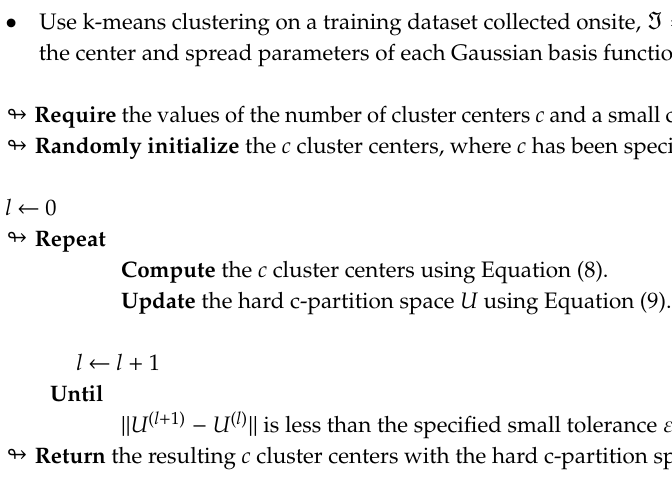
Algorithm 1. The two-stage method developed for the advanced AI k-means clustering-integrated RBF-ANN over fog-cloud analytics in this